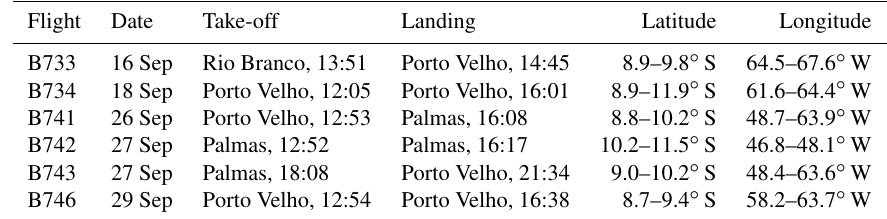
Table 4. Research flights of the SAMBBA field campaign considered in this article. Time is UTC. Flight Date Take-off Landing Latitude Longitude B733 16 Sep Rio Branco, 13:51 Porto Velho, 14:45 B734 18 Sep Porto Velho, 12:05 Porto Velho, 16:01 B741 26 Sep Porto Velho, 12:53 Palmas, 16:08 B742 27 Sep Palmas, 12:52 Palmas, 16:17 B743 27 Sep Palmas, 18:08 Porto Velho, 21:34 B746 29 Sep Porto Velho,